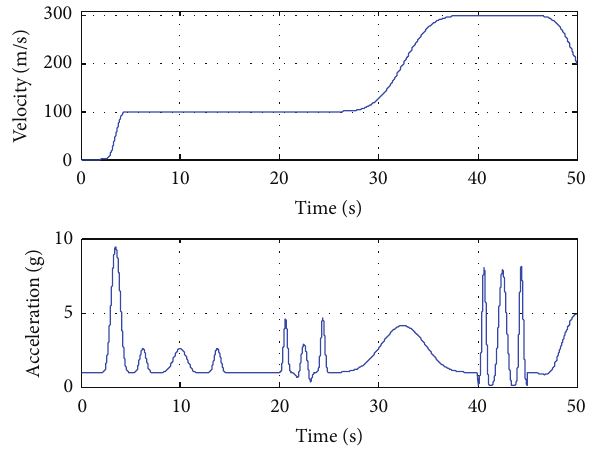
Figure 7: 3-dimensional position. Figure 8: Acceleration and velocity.